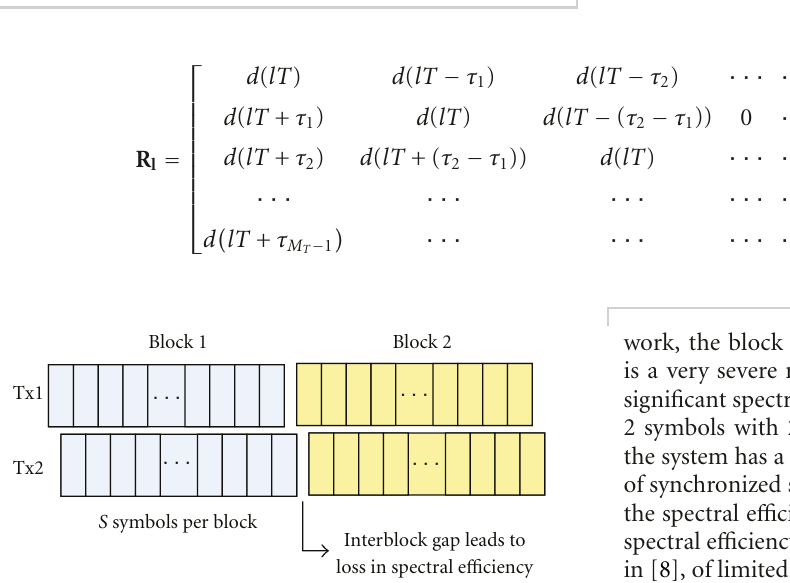
Figure 6: Block transmission